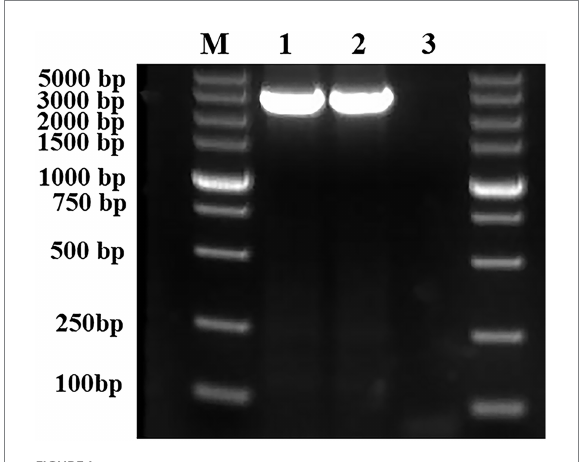
FIGURE 1 Validation of the structure of Escherichia coli ReJW5917. PCR products were detected using 2% agarose gel electrophoresis. Lane M represents the 5,000 bp DNA marker. Lane 1 contains the PCR product from E. coli K12. Lane 2 contains the PCR product from E. coli ReJW5917. Lane 3 contains the PCR product from E. coli